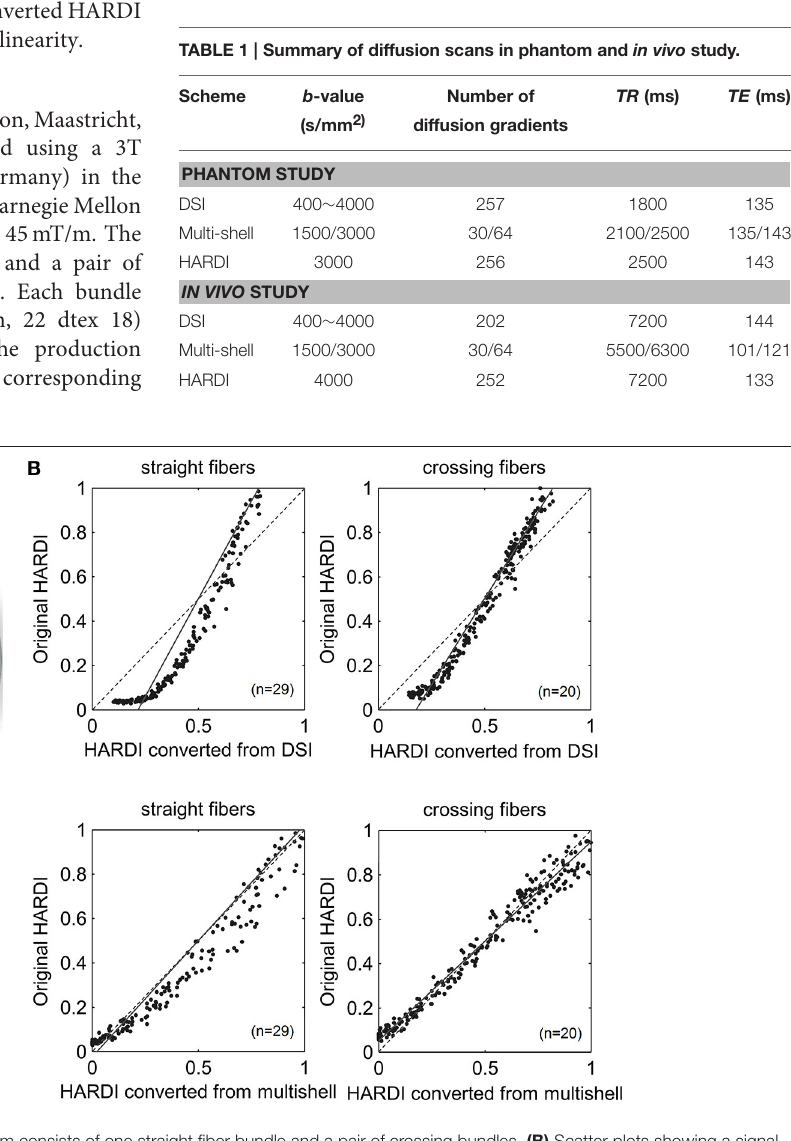
Frontiers in Neuroscience |